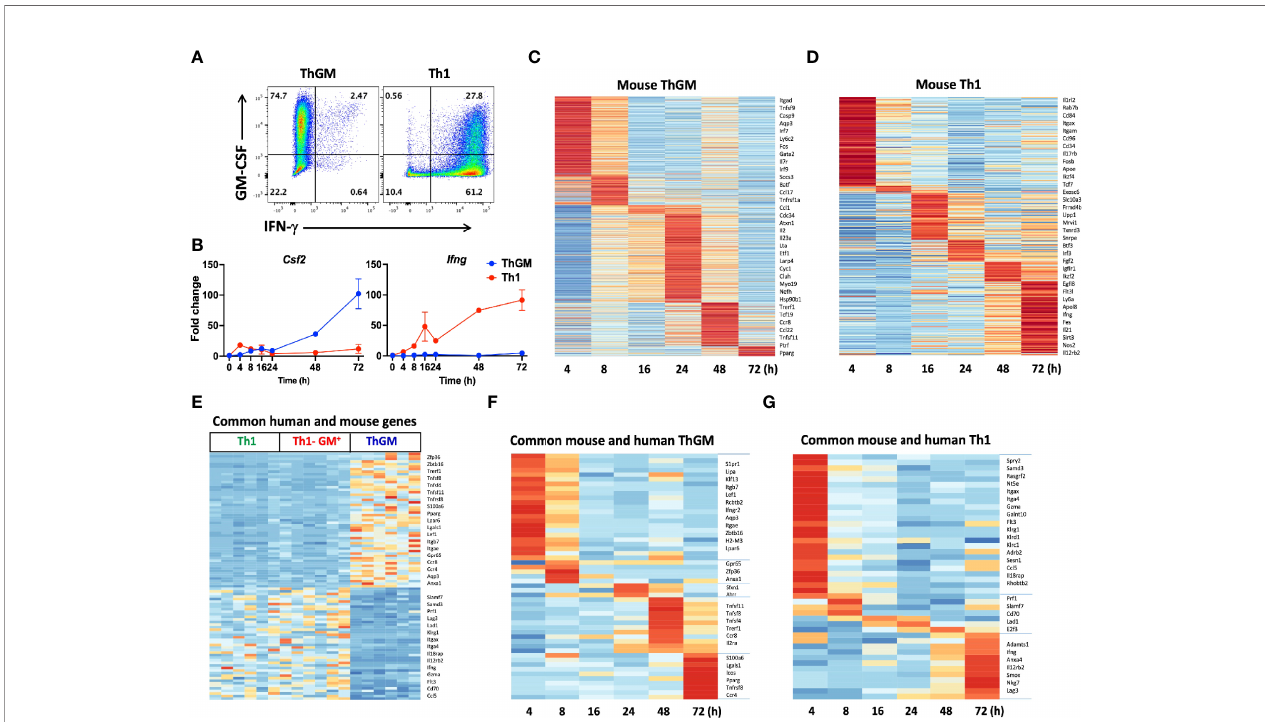
FIGURE 6 | Mouse and human ThGM cells have similar transcriptomes. Mouse 2D2 naïve CD4 + T cells were differentiated into ThGM and Th1 cells, their RNA was extracted at different time points and analyzed by RNA-seq. (A) Representaive fl ow cytometry plots showing GM-CSF and IFN- g expression by mouse ThGM and Th1 cells. (B) FPKM at different time points were normalized relative to FPKM of naive CD4 + T cells (0 h). Graphs showing fold change expression of GM-CSF and IFN- g by Th1 and ThGM cells. Heatmaps for ThGM (C) and Th1 (D) -speci fi c genes at different time points. (E) Differentially expressed genes by mouse and human ThGM and Th1 cells were compared. Heatmap showing expression of commonly expressed genes between in vitro -polarized mouse Th1 and ThGM, and natural human ThGM, GM-CSF + Th1, and Th1 cells. (F) Heatmap showing expression of commonly expressed genes between in vitro -polarized mouse and natural human ThGM and (G) Th1 cells. Data shown are mean ±